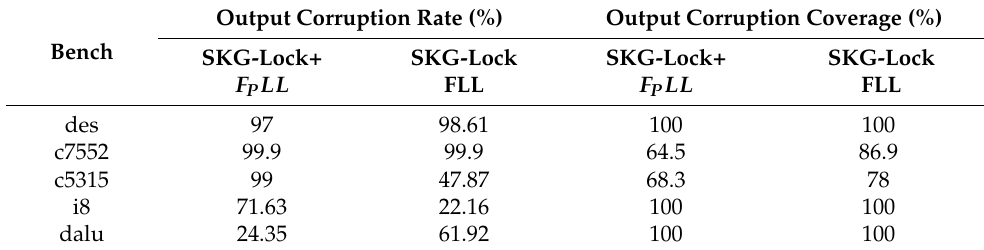
Table 4. Maximum output corruption of SKG-Lock+ ( n = 64).